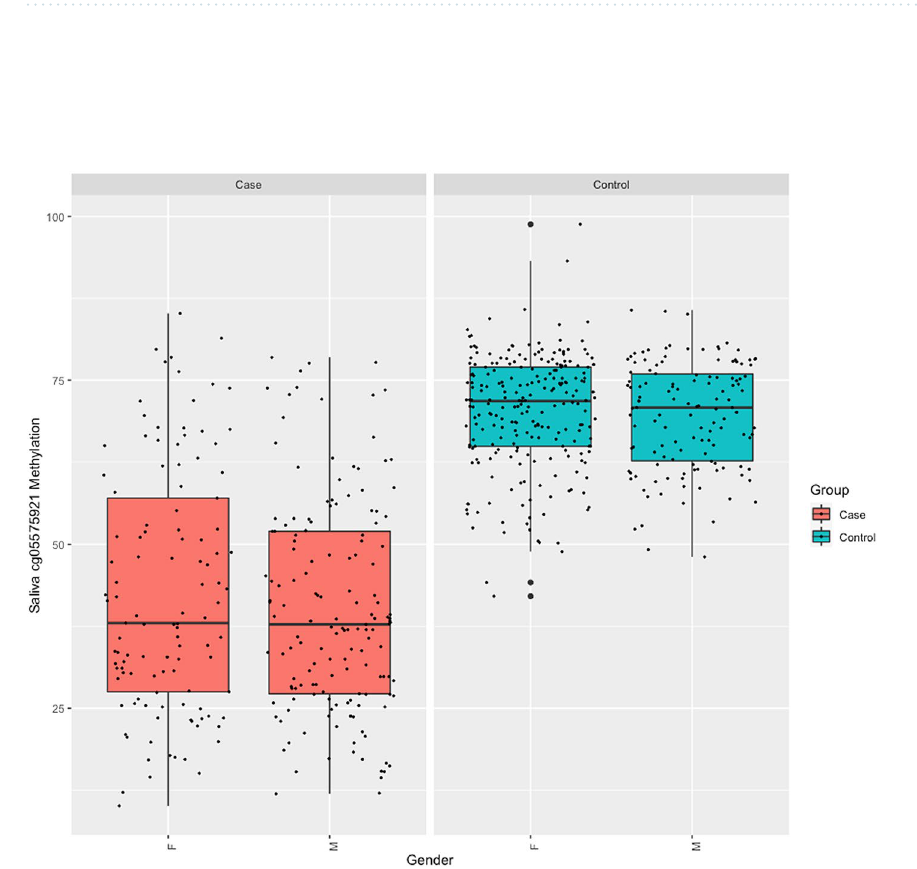
Figure 5. Box plots of the distribution of cg05575921 values in saliva samples from case (n = 266) and control (n = 363) subjects as a function of gender (M = male, F =